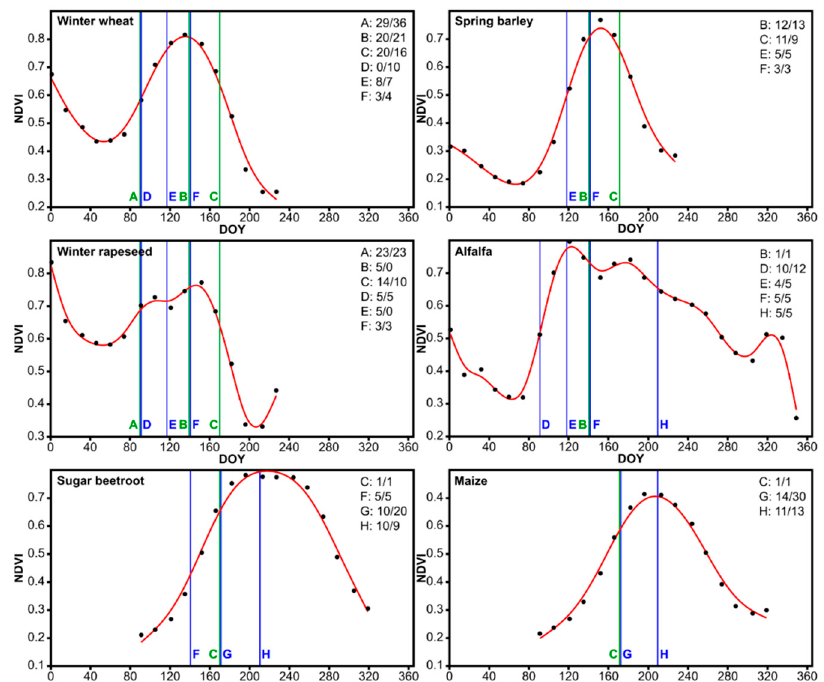
Figure 1. Typical NDVI profiles (extracted from series of Sentinel-2 data) of the agricultural crops considered in this study characterizing temporal changes of crop canopies during the growing season. Reference in situ data were collected during 8 field campaigns A (29–31 March 2017); B (17–19 May 2017), C (19–21 June 2017), D (4–5 April 2018), E (27–30 April 2018), F (21 May 2018), G (20–21 June 2018), and H (26 July 2018). Collected measurements were further divided into calibration/validation data subsets (203 calibration/188 validation points in 2017; 124 calibration/144 validation points in 2018). DOY (day-of-year) stands for the ordinal number of the day in the given year (i.e., 1.1. = 1, 2.1. = 2…31.12. = 365 etc.).